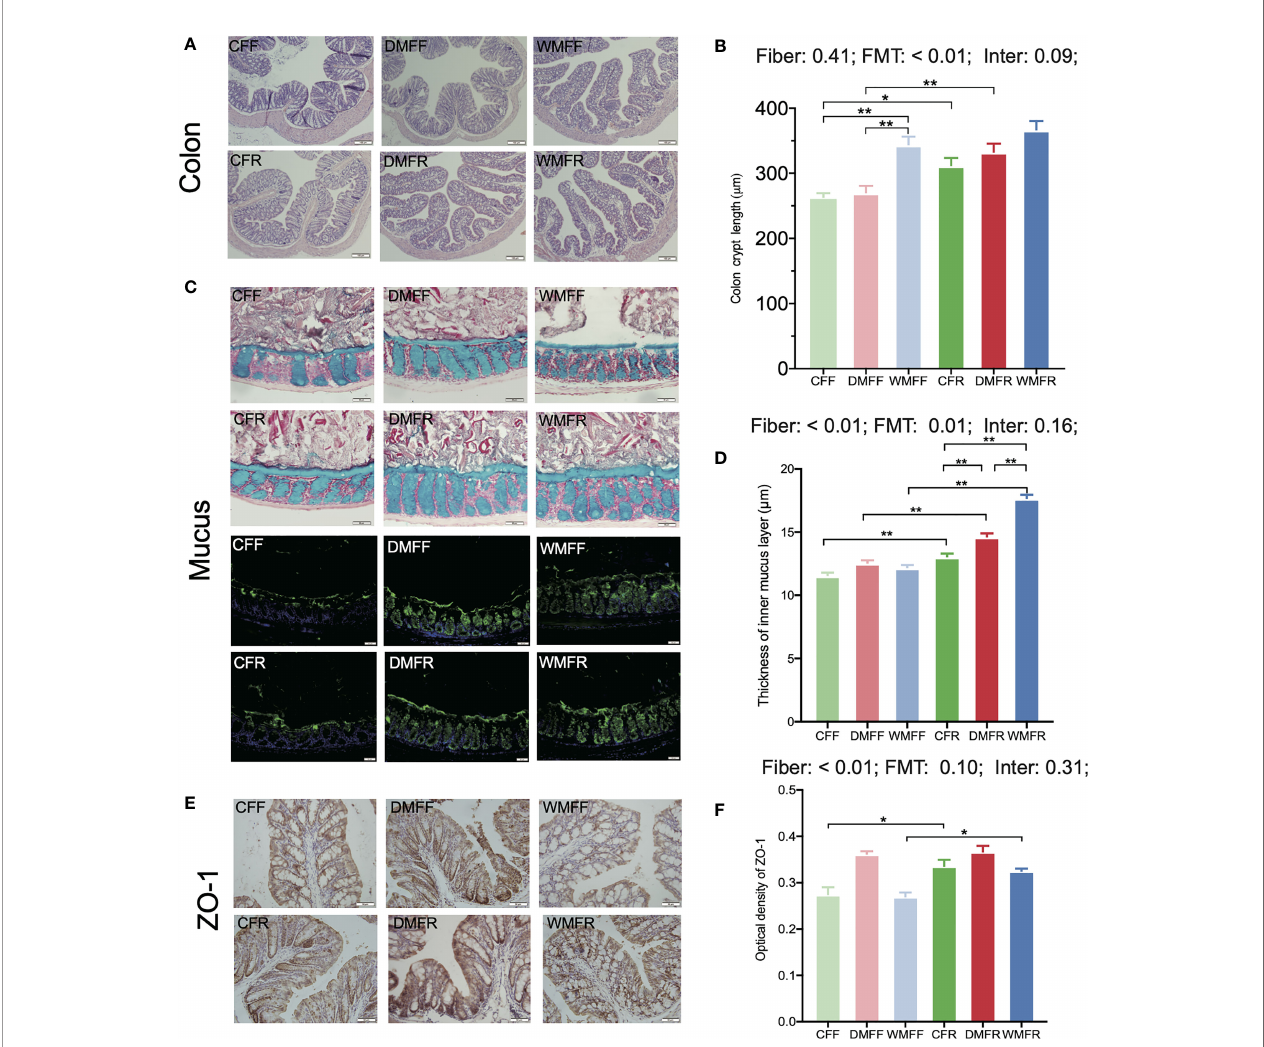
FIGURE 3 | Gut barrier in the mice fed a fi ber-free (CFF) or fi ber-rich (CFR) diet, or fecal microbiota transplantation (FMT) from domestic pigs and fed with a fi ber- free (DMFF) or fi ber-rich (DMFR) diet, or FMT from wild pigs and fed with a fi ber-free (WMFF) or fi ber-rich (WMFR) diet. (A, B) Gut morphology, (C, D) mucin barrier, and (E, F) tight junction protein in the colon of mice. Statistical differences among individual groups were evaluated using one-way ANOVA, and signi fi cance is de fi ned as * p < 0.05; ** p <